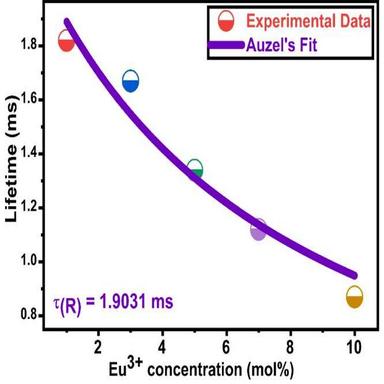
Effect of Eu3+ composition (1.0–10.0 mol%) on decay lifetime of Ba2La4Zn2O10 nanophosphor using Auzel's formulation.